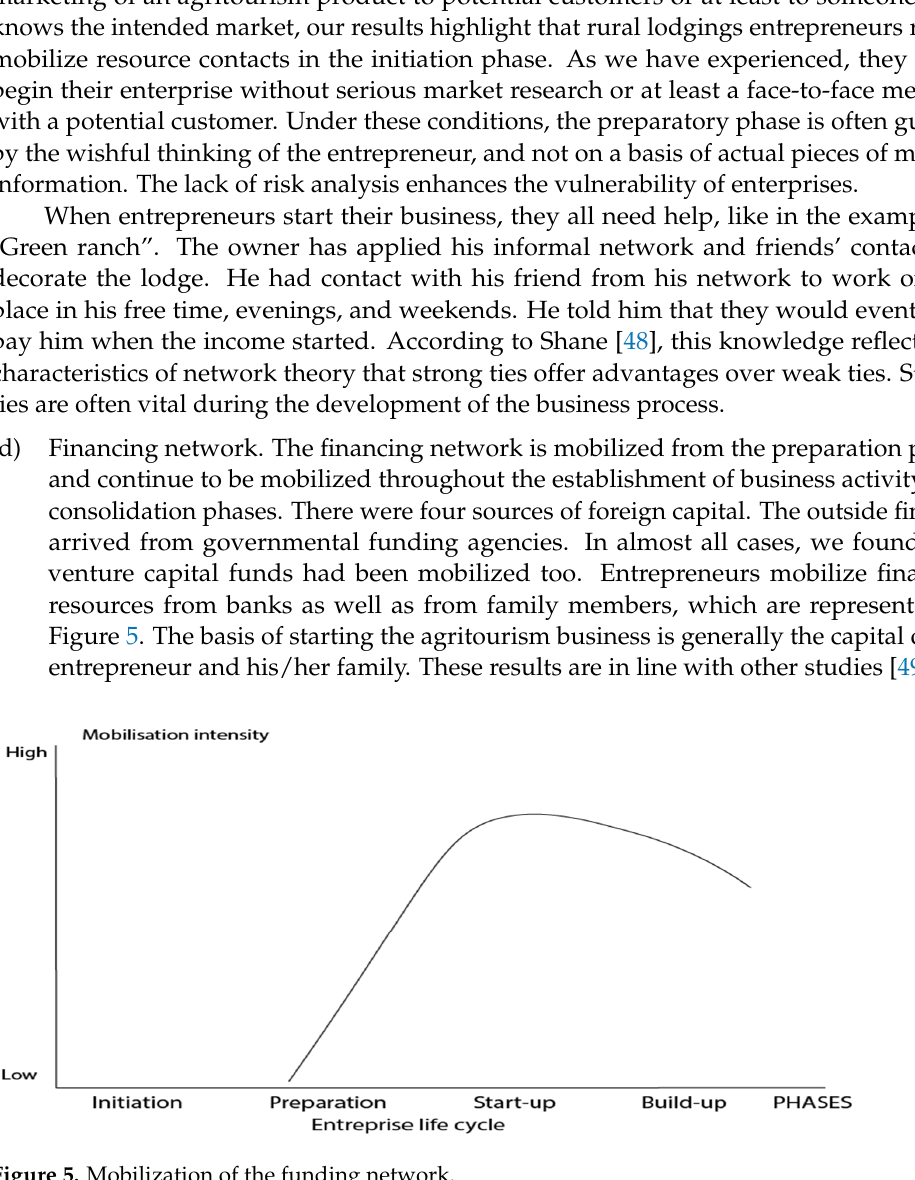
Figure 5. Mobilization of the funding network.